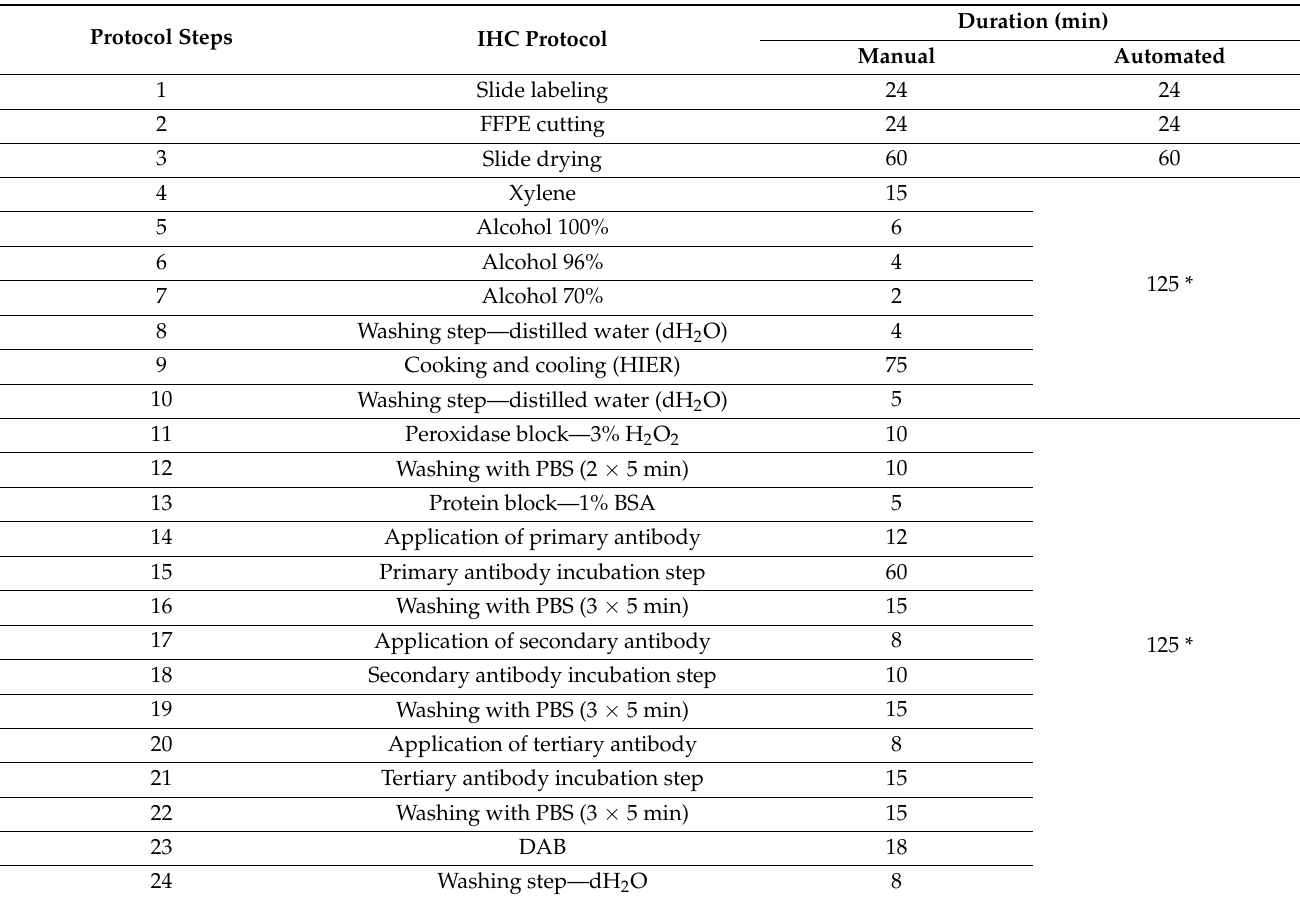
Table 1. Immunohistochemistry (IHC): protocol steps and IHC cycle duration in manual run and automated procedure using automated immunostainer (48